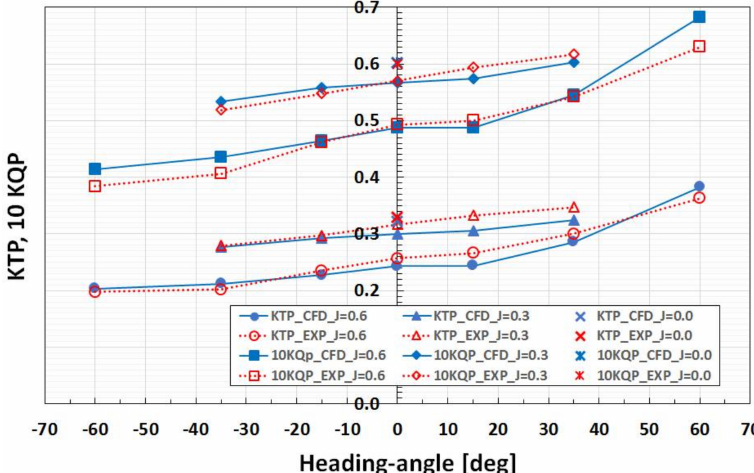
Figure 5. Measured (red) and computed (blue) propeller thrust, KTP, and propeller torque, KQP, at different heading angles and loading conditions.